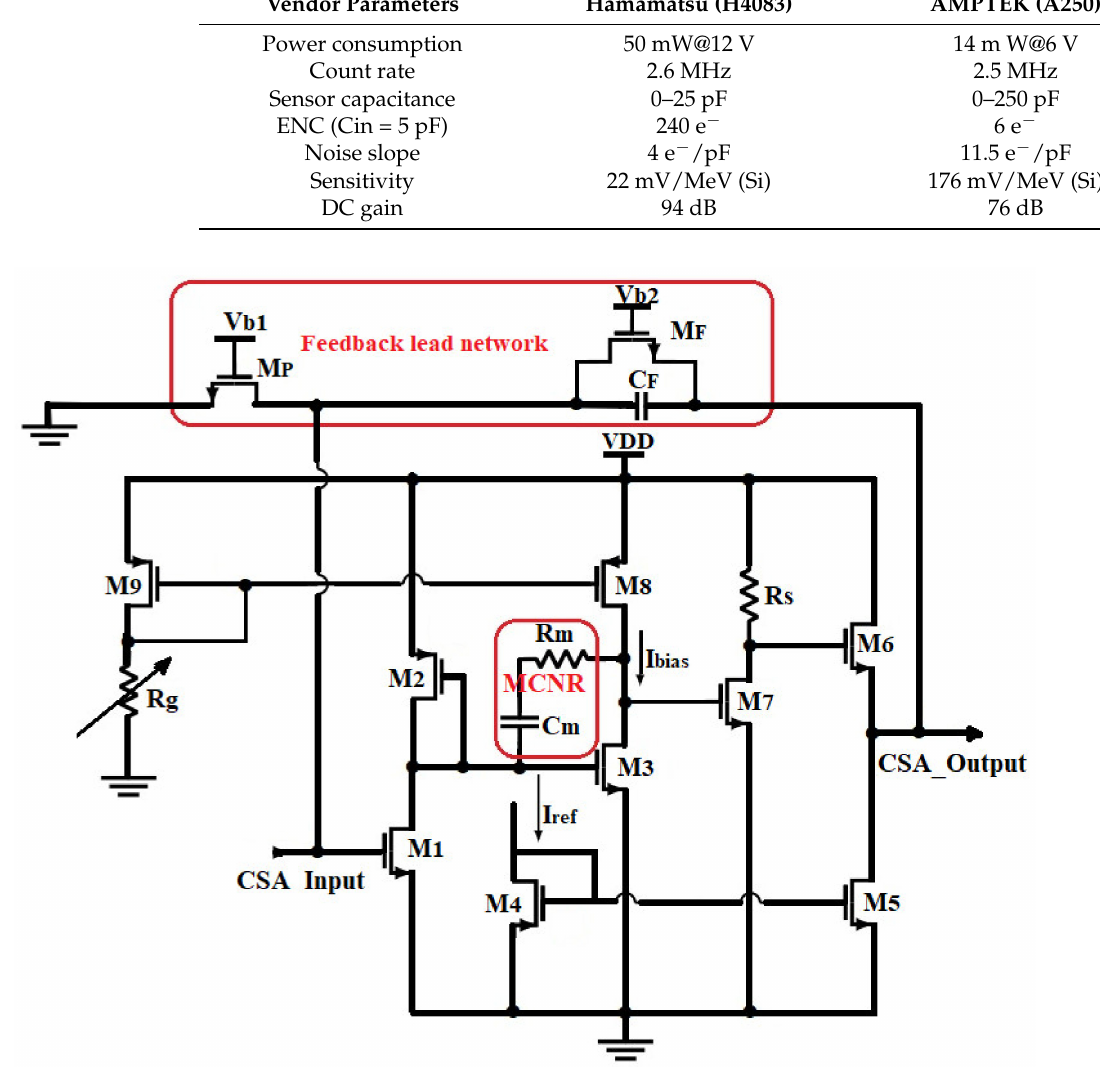
Figure 3. Schematic of the structure of the proposed